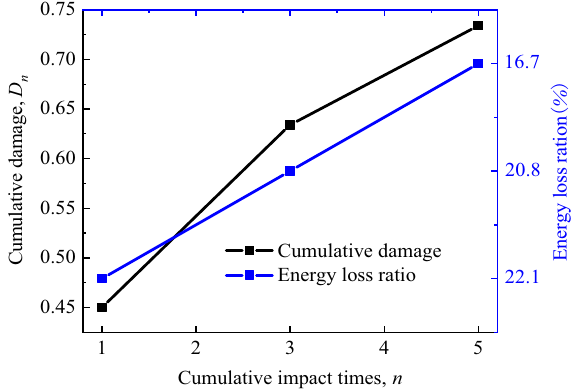
Figure 10. Cumulative damage and energy consumption